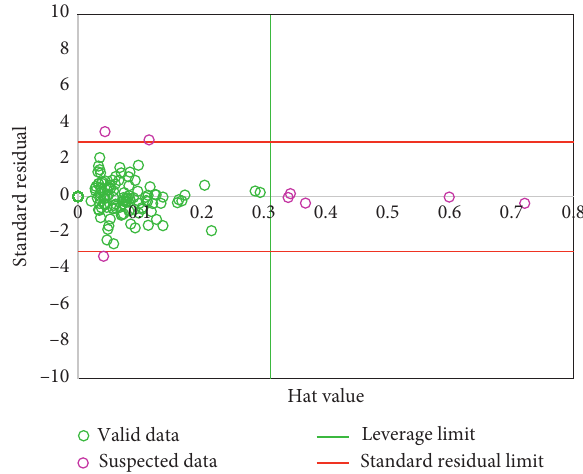
Figure 1: Determining reliable and suspicious data using William’s